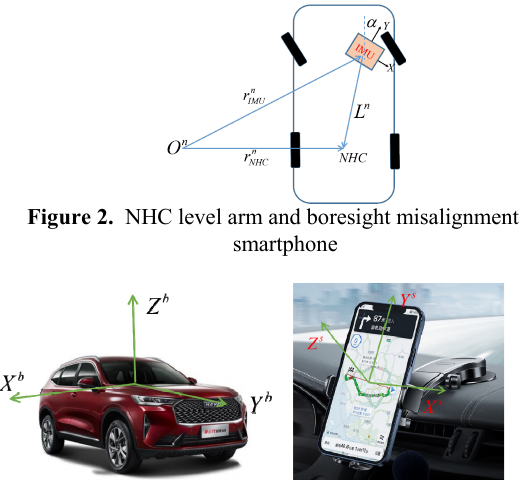
Figure 3. The vehicle frame and smartphone frame Assuming the centre of turning circle is n O and it is on the extension of the rear wheels’ connection, as shown in Figure 2.